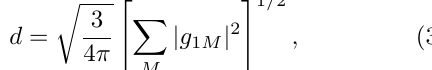
(cid:112) 3 / 4 π ). Results